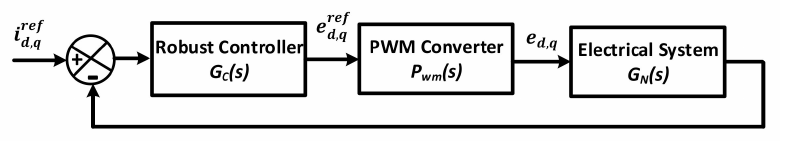
Figure 7. General block diagram for inner current